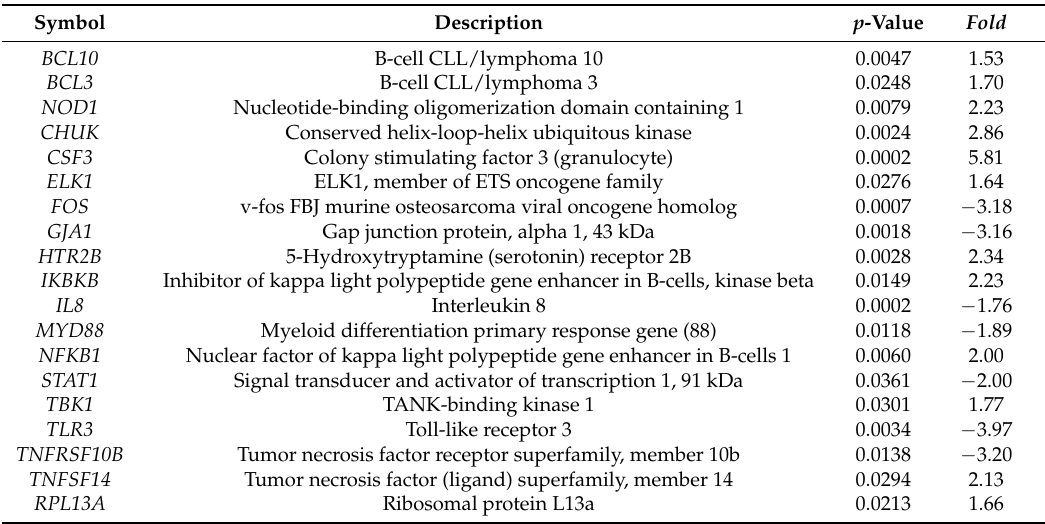
Table 1. Name and function of NF κ B-pathway genes differentially expressed between control